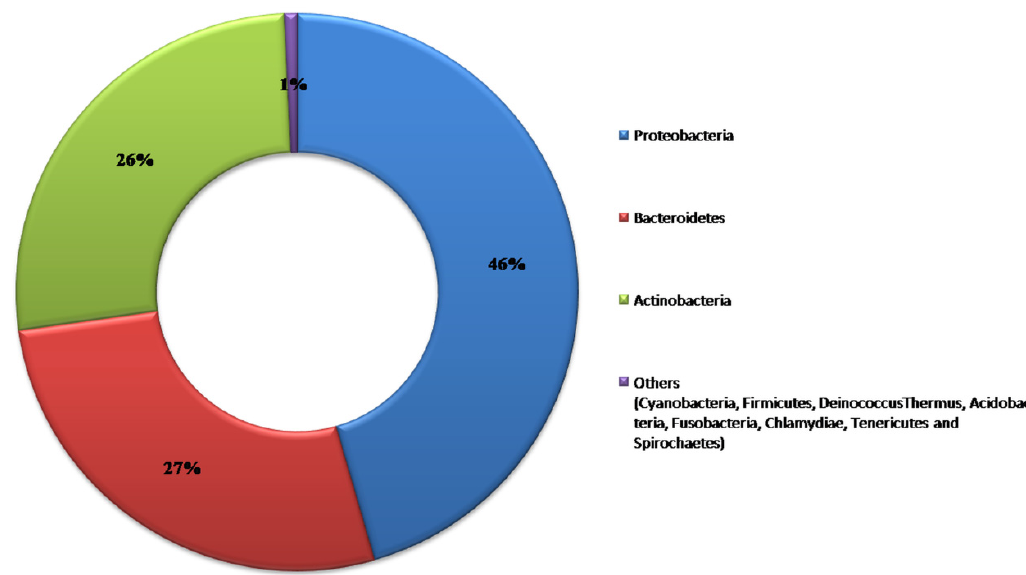
Figure 1. The abundance of bacteria among all grapevines based on the classified reads at the Figure 1. Abundance of bacteria among all grapevines based on the classified reads at the phylum level 2 phylum level.